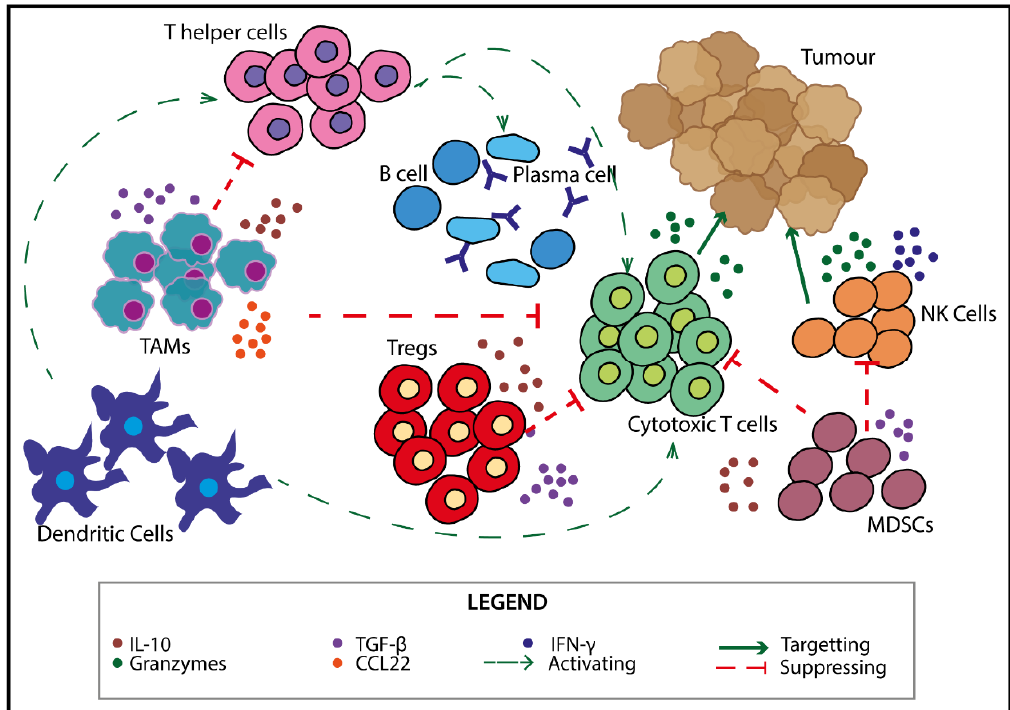
Figure 1. Immune cells in the tumour microenvironment (TME). There are multiple types of immune cells in the TME including dendritic cells (DCs), natural killer (NK) cells, myeloid-derived suppressor cells (MDSCs), tumour-associated macrophages (TAMs) and lymphocytes (B cells and T cells) which can impact the functions of one another. DCs interact with both T helper (Th) and cytotoxic T cells (CTLs) by activating them. The cells themselves can further interact with CTLs and B cells to boost activation. CTLs and NK cells directly act to kill tumour cells via the release of granzymes [47,48]. Pro-tumour cells such as regulatory T cells (Tregs), MDSCs and TAMs secrete immunosuppressive cytokines such as TGF-β and IL-10 which can inhibit CTLs and NK cell functions [49–53].